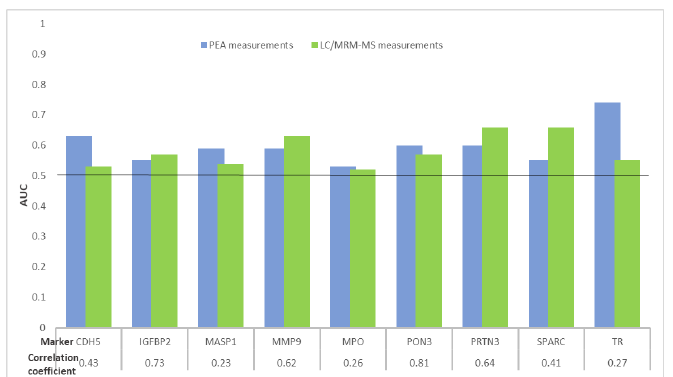
Figure 2. Distribution of AUCs of nine protein biomarkers overlapping between PEA and LC/MRM-MS measurements for detecting CRC cases from participants in screening colonoscopy. Abbreviations: AUC, area under the receiver operat- ing curve; CDH5, cadherin 5; CRC, colorectal cancer; IGFBP2, insulin-like growth factor binding protein 2; LC/MRM-MS, liquid chromatography/multiple reaction monitoring–mass spectrometry; MASP1, mannan binding lectin serine protease 1; MMP9, matrix metalloproteinase 9; MPO, myeloperoxidase; PEA, proximity extension assay; PON3, serum paraoxonase lactonase 3; PRTN3, myeloblastin; SPARC, secreted protein acidic and rich in cysteine; TR, transferrin receptor protein 1.